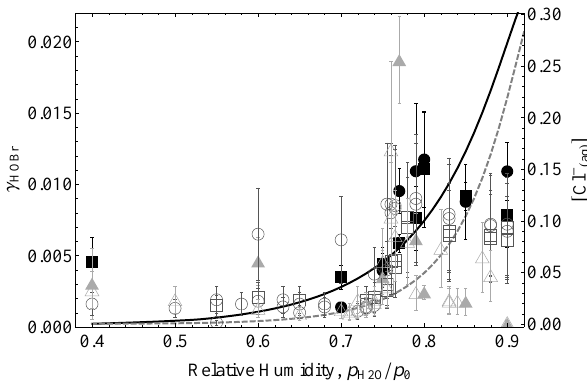
Figure 2. Dependence of reactive uptake coefficient for HOBr on relative humidity (RH) in the experiments of Pratte and Rossi (2006) on H 2 SO 4 -acidified sea-salt aerosol (H 2 SO 4 :NaCl = 1.45:1) at 296K, on acidified sea salt (circles), recrystallised sea salt (squares) and natural sea salt (triangles), under two exper- imental setups: (i) the observed rate of HOBr ( g ) decay for a mea- sured aerosol size distribution, with effective radius ranging over 165–183nm (filled shapes), and (ii) a survey type mode with HOBr depletion monitored as a function of RH (unfilled shapes, with re- ported error estimated at 30–50%) over a constant reaction time. Also shown is the modelled uptake coefficient for HOBr (black line), and the Cl − molarity (dotted line) as used within the up- ( aq ) take